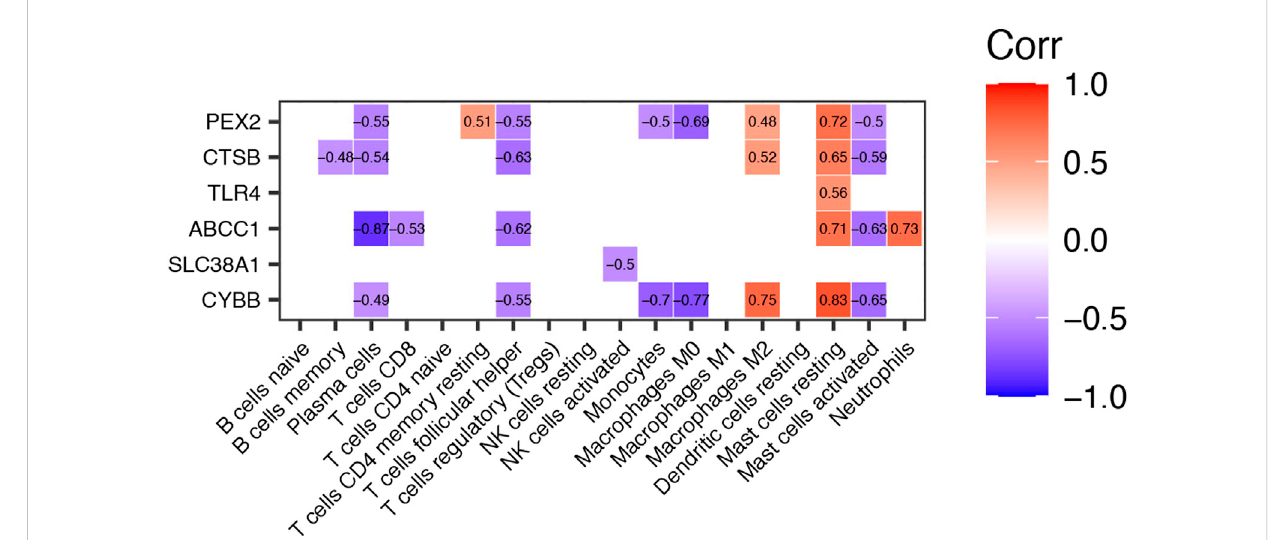
FIGURE 6 Correlation Heatmap of Differentially expressed FRGs and Immune Cells in TAO groups. The value within each square is the Spearman R and only those values where Spearman R > 0.4 or < − 0.4 and p -value < 0.05 are displayed.